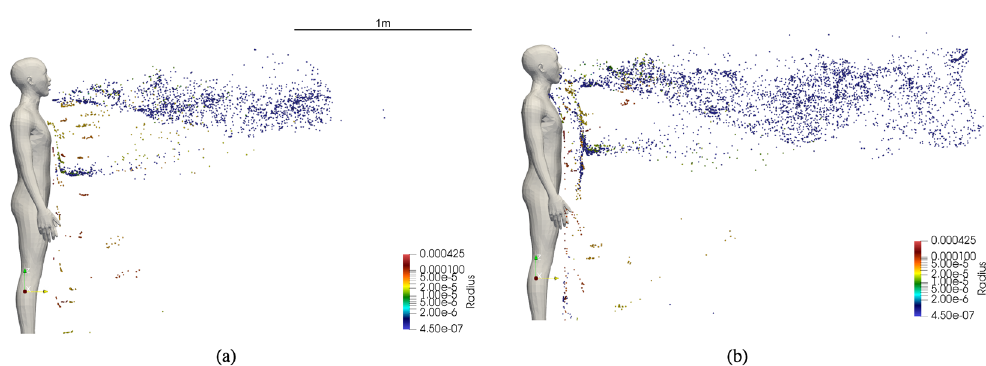
Figure 5. Dispersion of droplets during continuous speech at ( a ) t = 12 s ( b ) t = 24